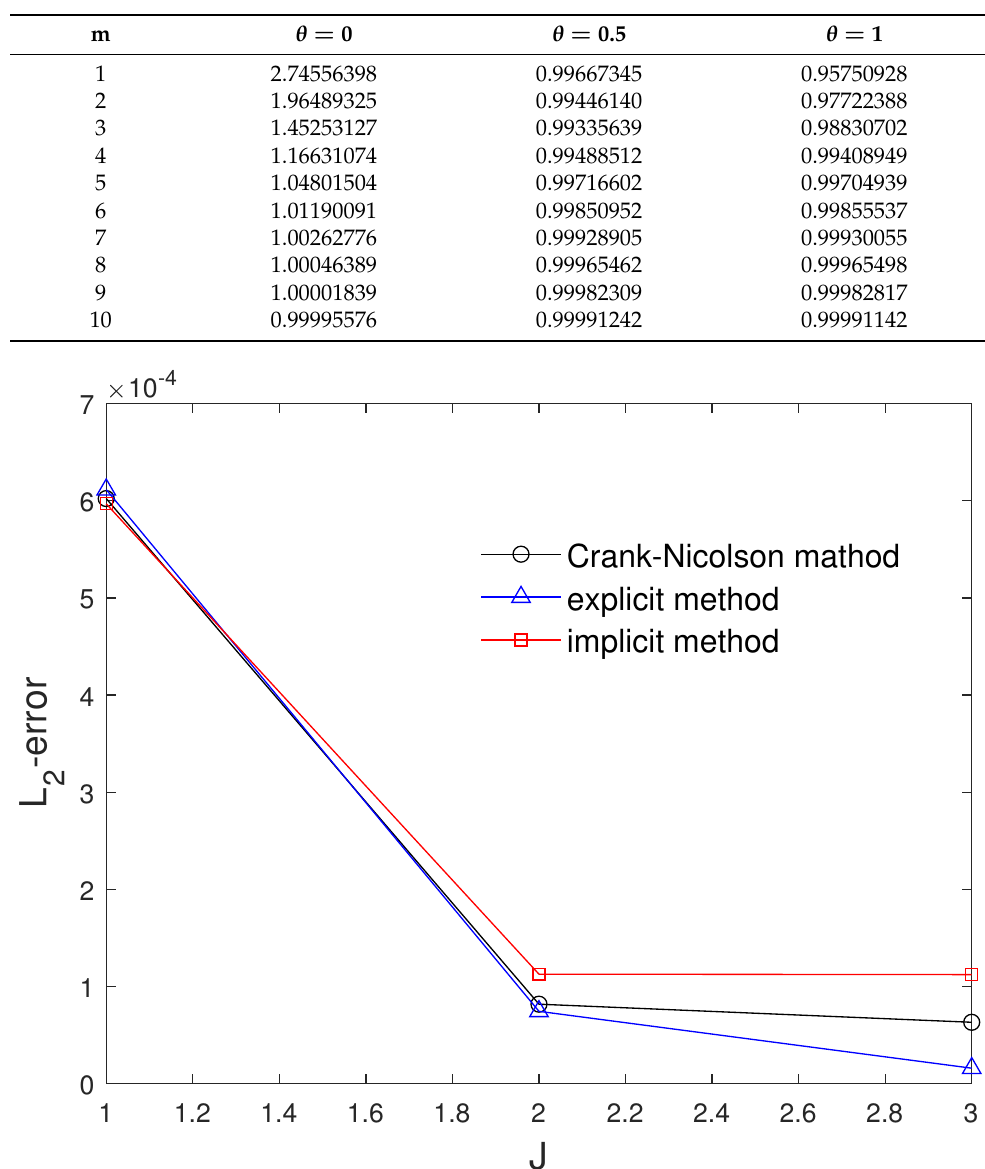
Table 4. L 2 norm of errors taking r = 5, J = 2, θ = 1/2 and δ t = 0.1/2 m − 1 for Example 1.